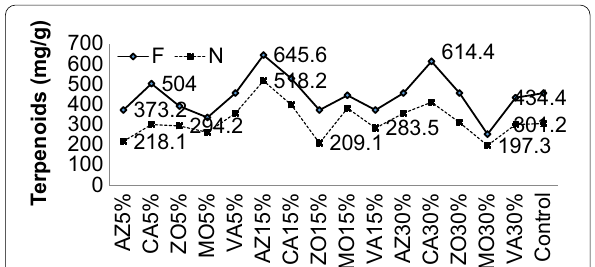
Fig. 1 Terpenoids activity in rice plants exposed to the experimental conditions. Keys: N plant innon-ferruginous soil, F plant inferruginous